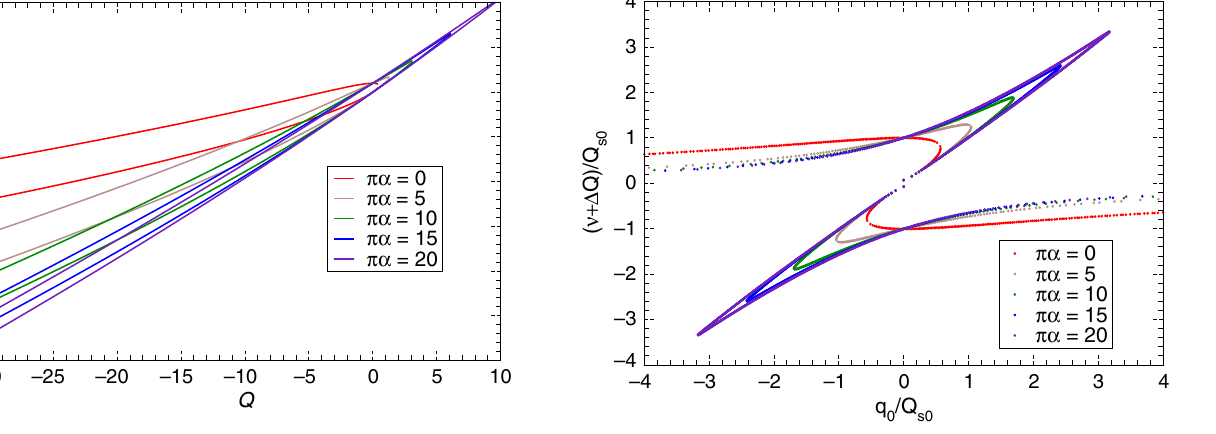
FIG. 11. Lowest eigentunes of the bunch against the exponen- tial wake strength at Δ Q ¼ 0 .